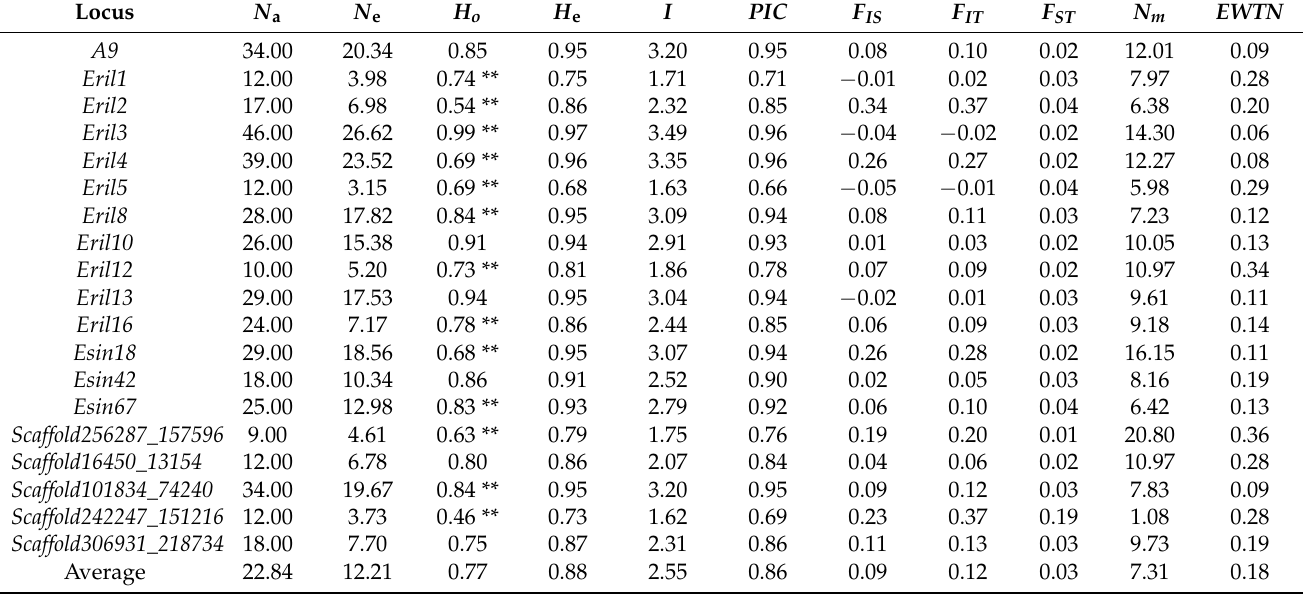
Table 2. Genetic diversity of 19 microsatellite loci in three Eriocheir s. s.